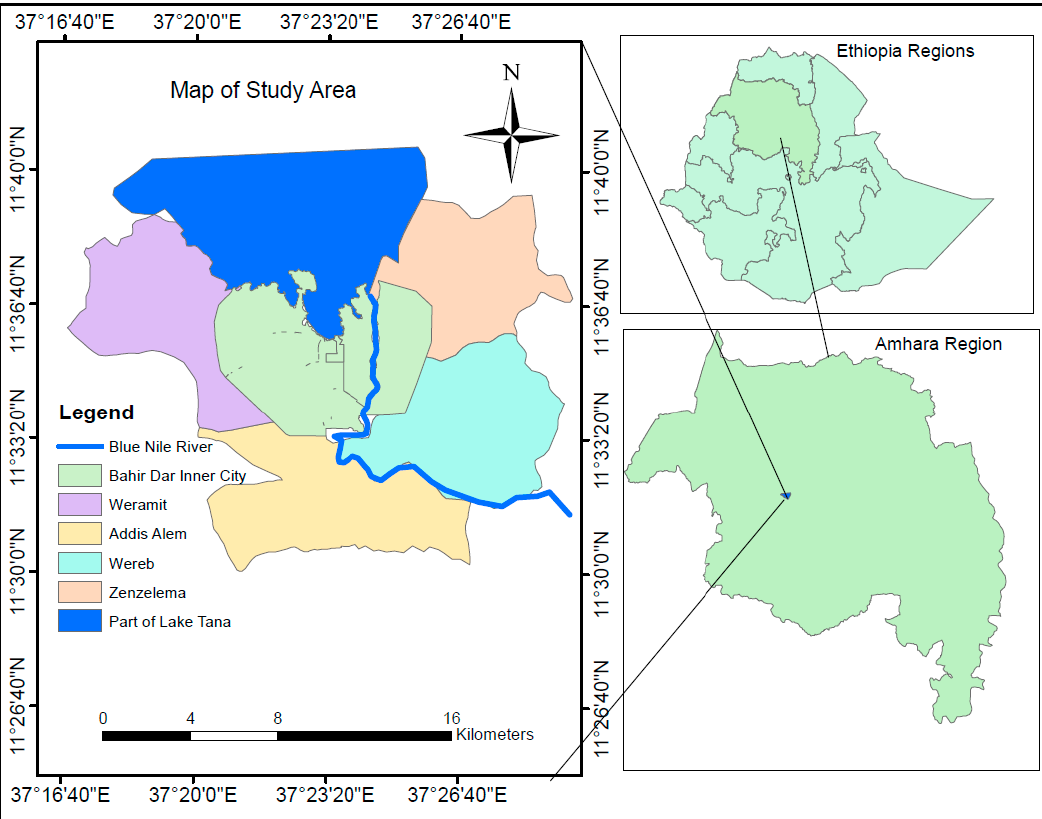
Figure 1. Study area map (Source: Authors).